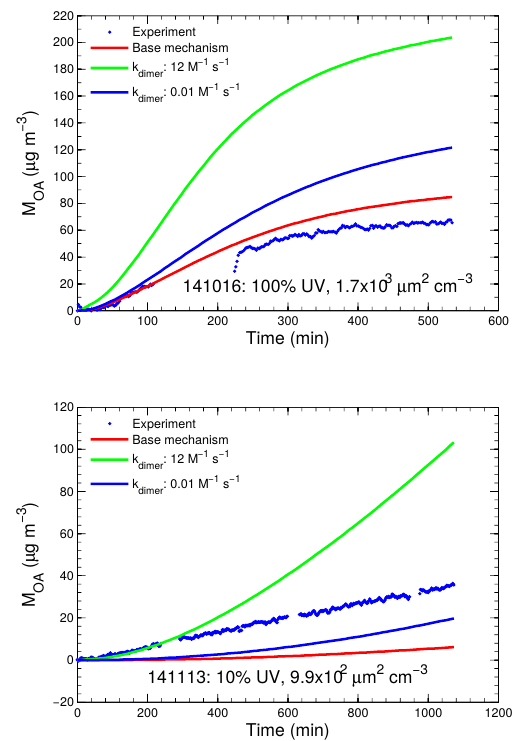
Figure 8. Mass of SOA as a function of time for one 100% UV experiment and one 10% experiment. Experimental data are shown with filled circles. Solid lines show GECKO-A predictions for the base case and then with two values of a condensed-phase dimeriza- tion rate constant, with all simulations using k gw = 10 − 3 s − 1